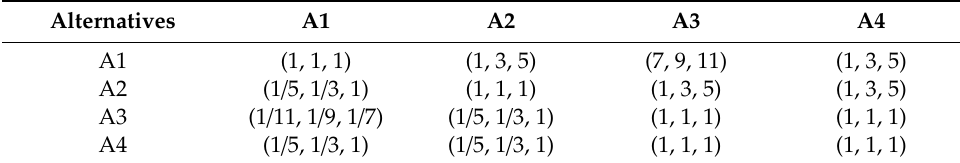
Table 13. Evaluation with respect to the budgetary